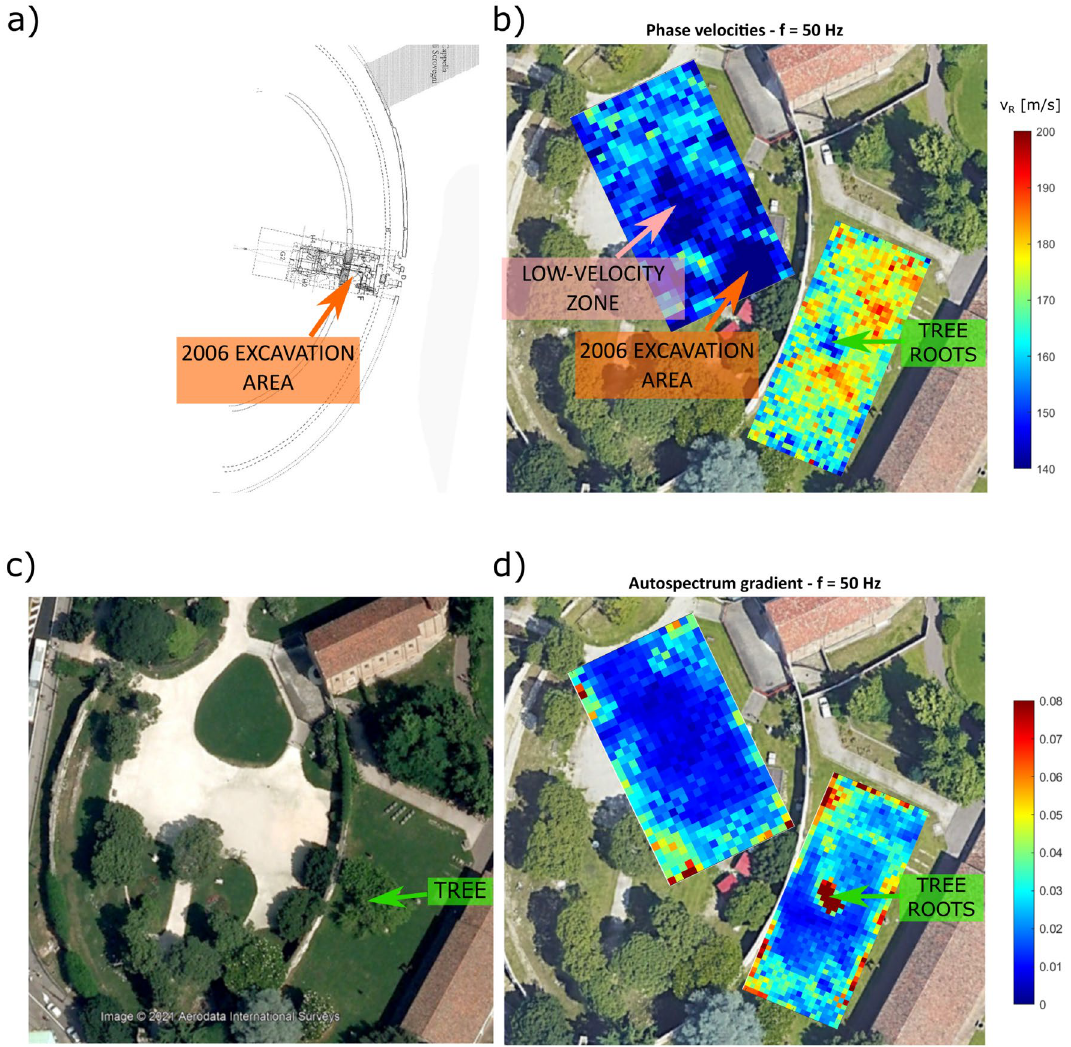
Figure 3. ( a ) Detail of the reconstruction of the amphitheater given by Ruta et al. 28 , including the 2006 excavation area (modified from Bressan 27 ) ( b ) Phase velocity map for 50 Hz. ( c ) Satellite image dating 2009 (from Google Earth). ( d ) Autospectrum gradient map for 50 Hz. The corresponding features are highlighted with arrows of the same